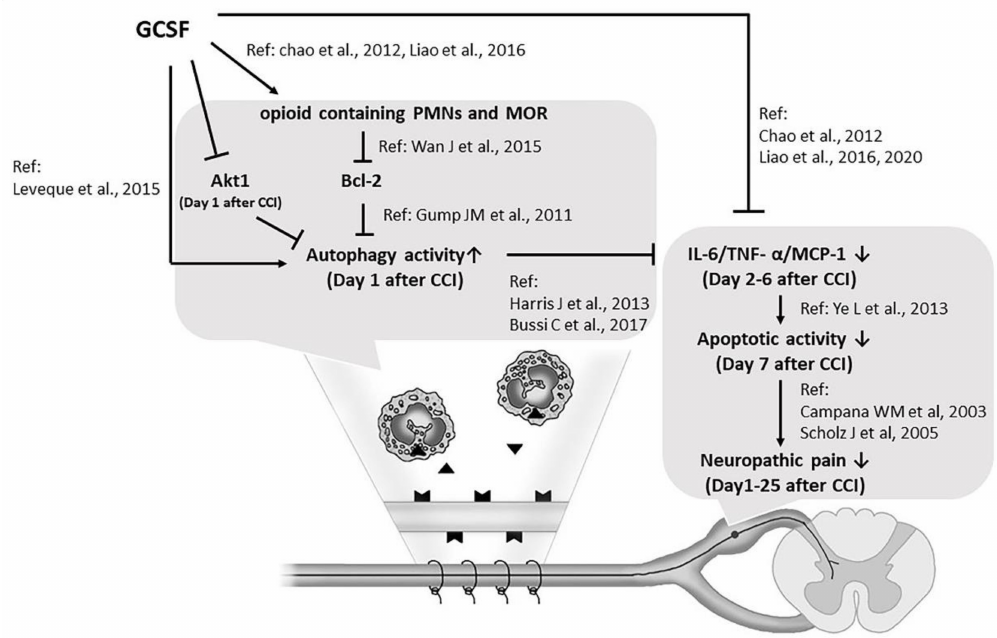
Figure 7. G-CSF is a multipotent agent for treating neuropathic pain. G-CSF upregulates MOR expression and autophagic activity in the injured nerve in the early phase, suppresses proinflammatory cytokine expression in DRG neurons, and thereafter downregulates apoptotic activity in DRG neurons, thus attenuating neuropathic pain. ( (cid:72) , Opioid; , Mu opioid receptor; ↑ : increase; ↓ : decrease; → : enhance; —|: